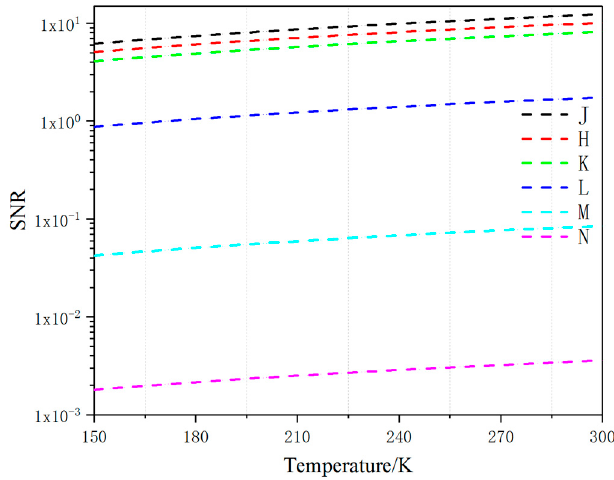
Figure 5. Relationship between target surface temperature and SNR.